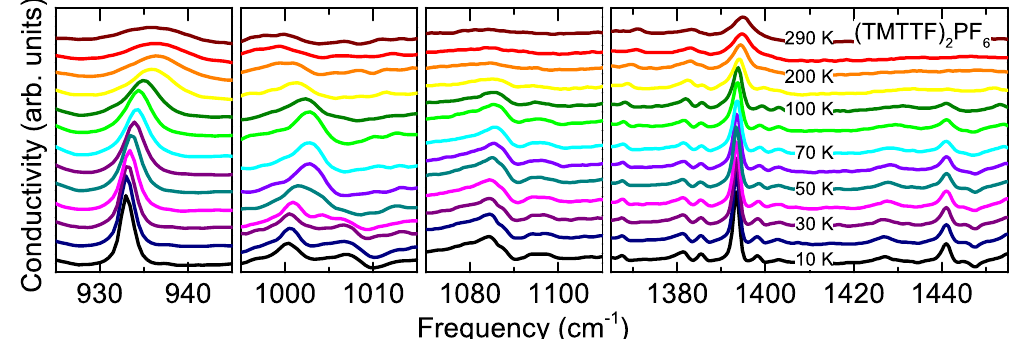
Figure 14. Temperature dependence of the vibrational modes observed in the optical conductivity of (TMTTF) PF for the polarization direction E (cid:107) c . The curves are shifted 2 6 for clarity